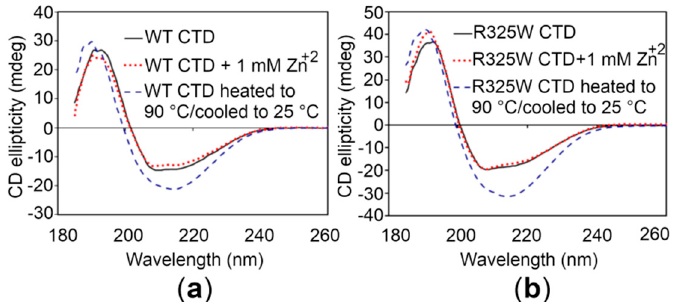
Figure 4. Circular dichroism (CD) spectroscopy of the hZnT8 CTDs. ( a , b ) CD spectra of the WT CTD ( a ) and the R325W CTD ( b ) in the absence (black continuous lines) and in the presence (red dotted lines) of 1 mM Zn + 2 . Blue dotted lines represent the CD spectra of the CTDs that were heated up to 90 °C followed by an attempt of refolding upon cooling to 25 °C.